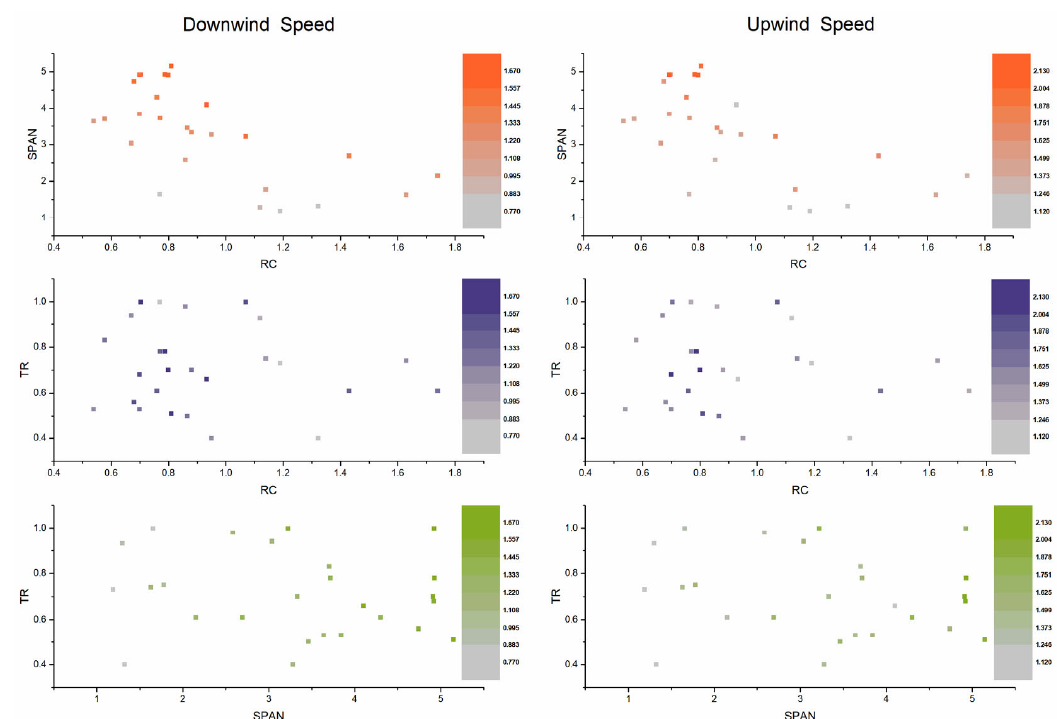
Figure 14. Pareto front of designs.